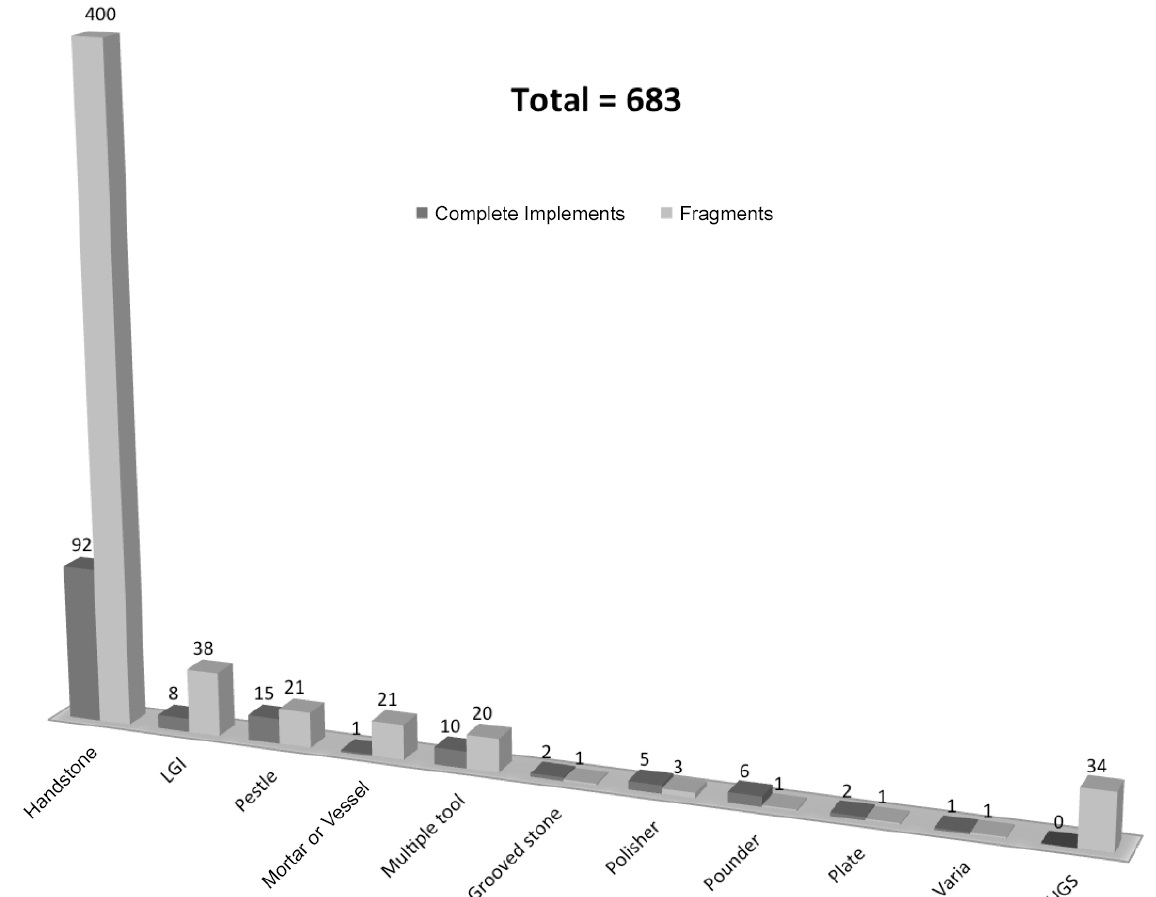
Figure 5: Total number of tool fragments and complete implements in the late Natufian assemblage of Shubayqa